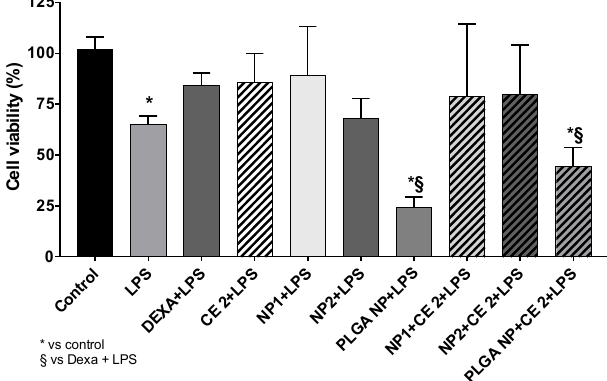
Figure 2. Cell viability. HUVEC were treated with empty or CE-loaded NPs (QA-Ch-NP: NP1; QA-Ch-S-pro-NP: NP2; and PLGA NPs), with 2 µg/mL GAE of CE (CE 2) or DEXA (5 µg/mL) for 2 h and with lipopolysaccharide (LPS) (10 µg/mL) for 24 h. Data are the means ± SD of three independent experiments. * p < 0.05 vs. Control and § p < 0.05 vs. DEXA + LPS.